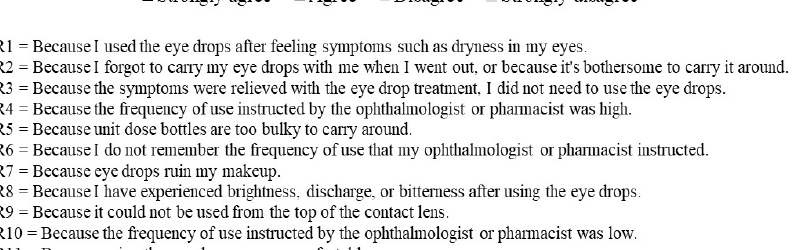
We considered that it was important to instill eye drops not only at the fixed fre- quency but also regardless of the symptoms, and so we examined the relationship be- tween eye drop use and subjective symptoms. Figure 3 shows the distribution of participants according to actual usage pattern for subjective symptoms and medication instruction knowledge status. Regarding the actual usage pattern of participants, 61.3% of participants instilled the DED eye drops when they felt subjective symptoms. In contrast, regarding the usage pattern in the medication in- struction, 51.8% of participants were instructed to use the DED eye drops at the specified frequency regardless of subjective symptoms. The distribution of participants according to actual usage pattern and medication in- struction knowledge status for the three types of DED eye drops is shown in Table S4. There was no difference in the proportion of patients according to the actual usage pattern and medication instruction knowledge status among the three groups categorized by eye drop type.